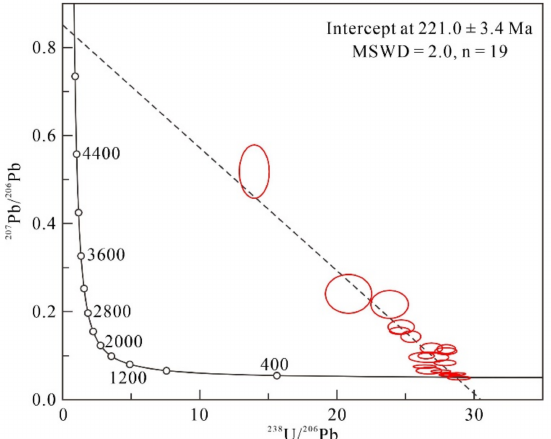
Figure 7. Tera–Wasserburg plots and the lower intercept’s age of wolframite sample BST-17 from the Baishitouwa deposit.